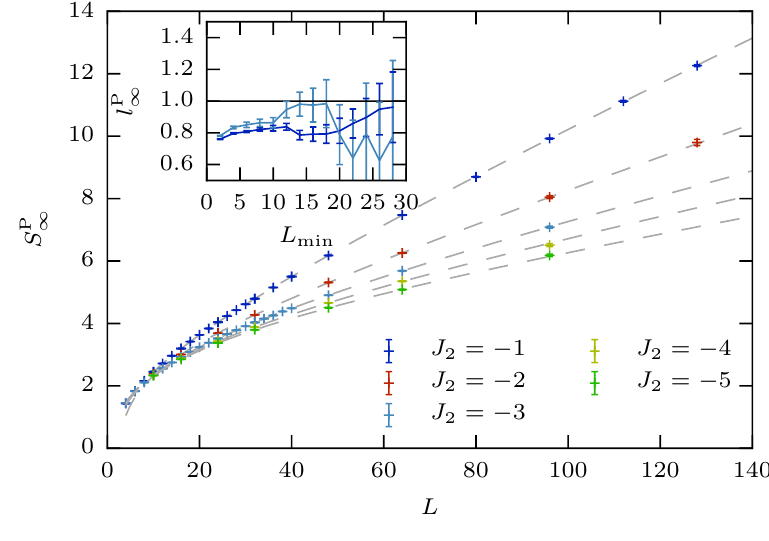
Figure 2: Participation entropy S P of the line shaped subsystem for the T = 0 two-dimensional ∞ (panel (a) of Fig. 1) S = 1 / 2 Heisenberg model [ Eq. (2) ] at different values of J . The inset 2 shows the prefactor of the logarithmic term obtained from fits to the form Eq. (8), using differ- ] as a function of L = − 1 and J = − 3, ent fit windows [ L , L for the two values of J min max min 2 2 for which we have collected data on the finest grid in system size. L is the maximal linear max system size, ranging from 96 to 128. Our results are consistent with a universal logarithmic / 2 = 1, since for fit windows that include only large system sizes, the term with l ∞ = n NG obtained l ∞ is close to 1 within